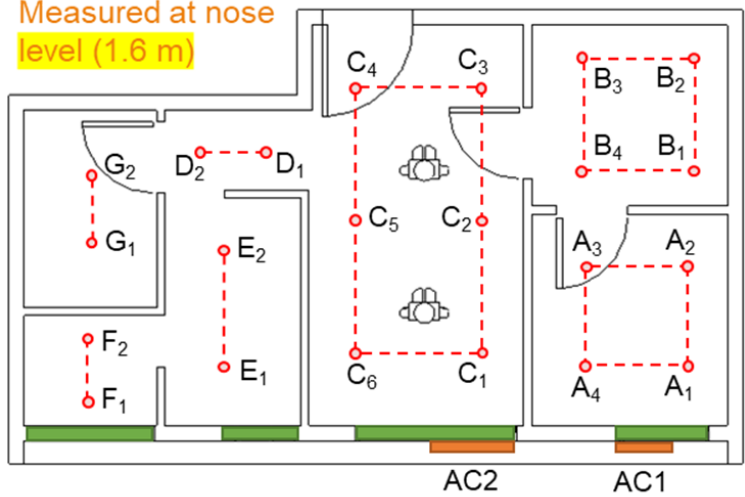
Figure 5. Data collection points for field measurement.